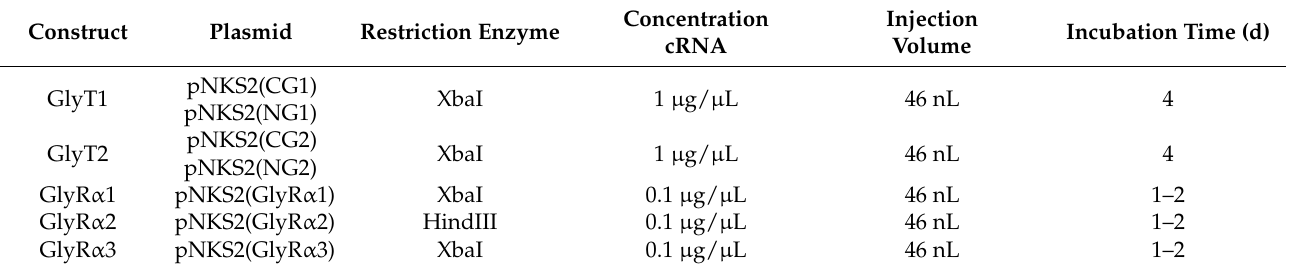
Table 1. cRNA synthesis and